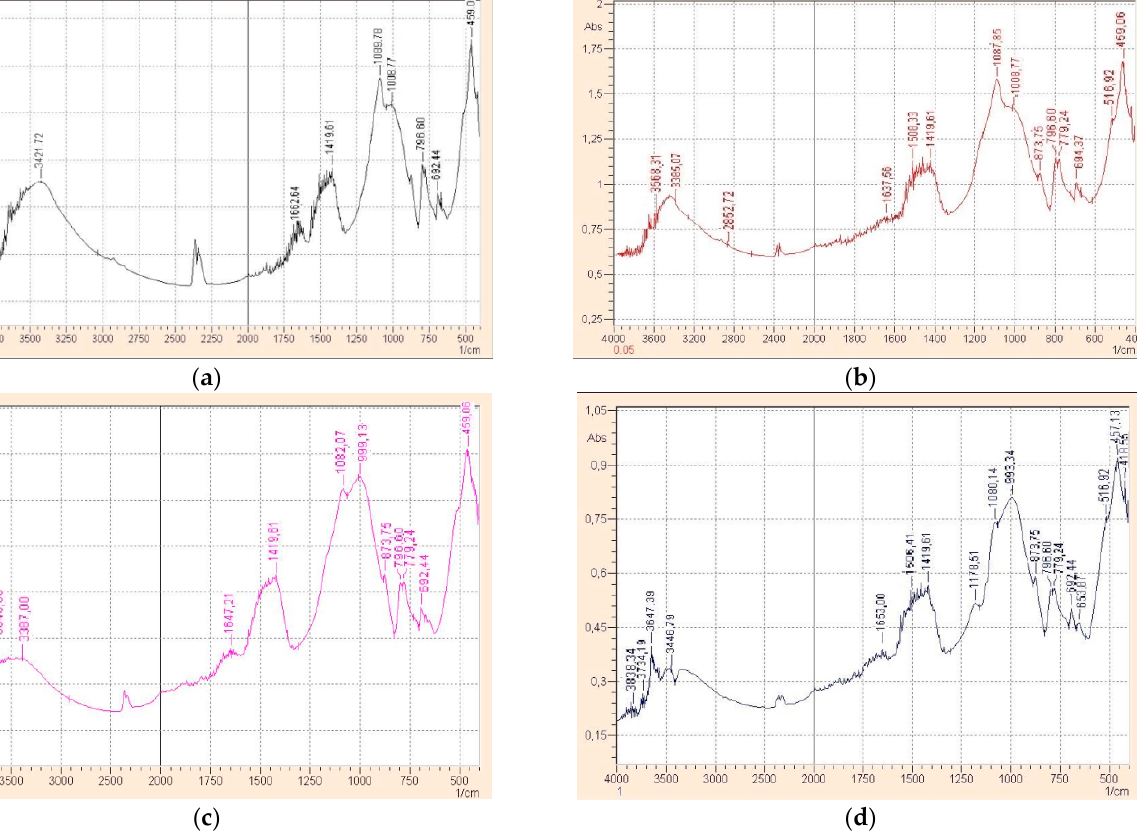
Figure 4. IR spectra of: ( a ) reference sample, ( b ) sample modified with the carbon black in the amount of 0.01% by cement mass, ( c ) sample modified with chrysotile dispersion in the amount of 0.05% by cement mass, ( d ) sample modified with the complex additive.